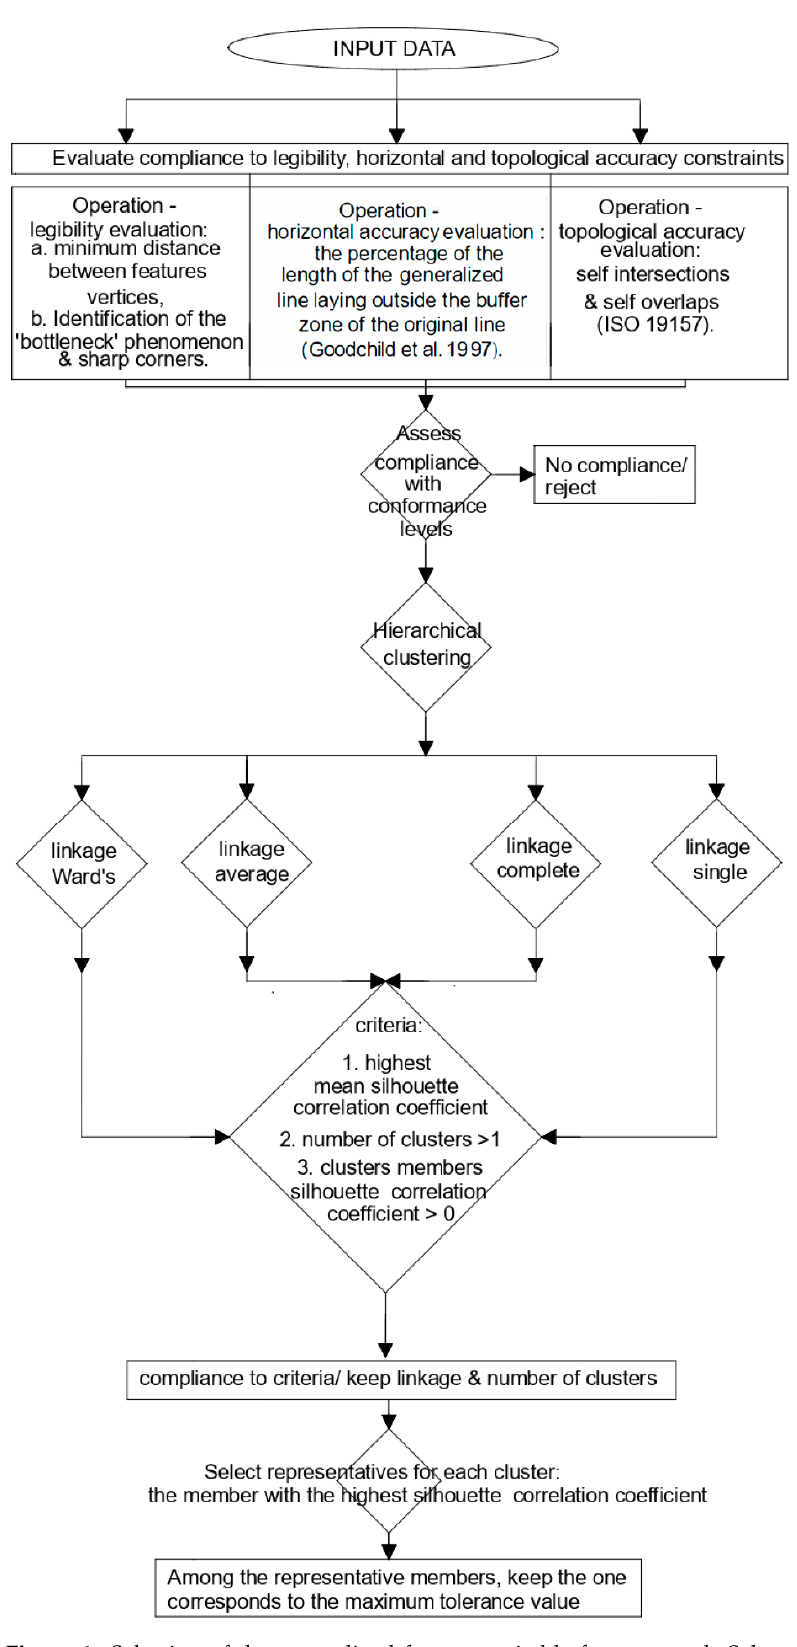
Figure 4. Selection of the generalized features suitable for portrayal: Select the one among the representatives that corresponds to the maximum tolerance value (operation-horizontal accuracy evaluation [38]).